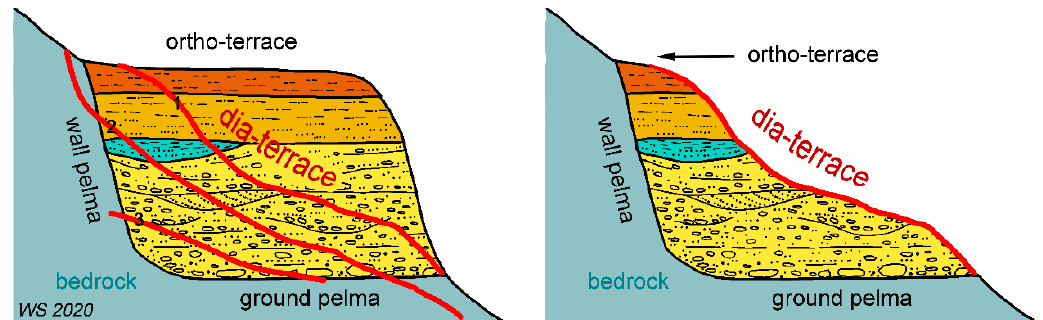
(red lines) generates dia-terraces. Shown are three random stages (1–3) of dia-terraces, leaving behind Figure 4. Changing geometry of terraces. Dia ‐ terrace: a complete flument when diagonally cut (red more or less volume of the previous lines) generates dia ‐ terraces. Shown are three random stages (1–3) of dia ‐ terraces, leaving behind more or less volume of the previous flument.